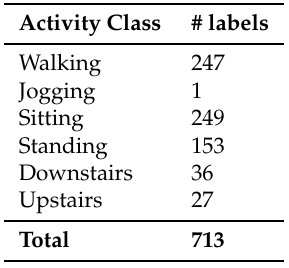
Table 3. The number of activity labels